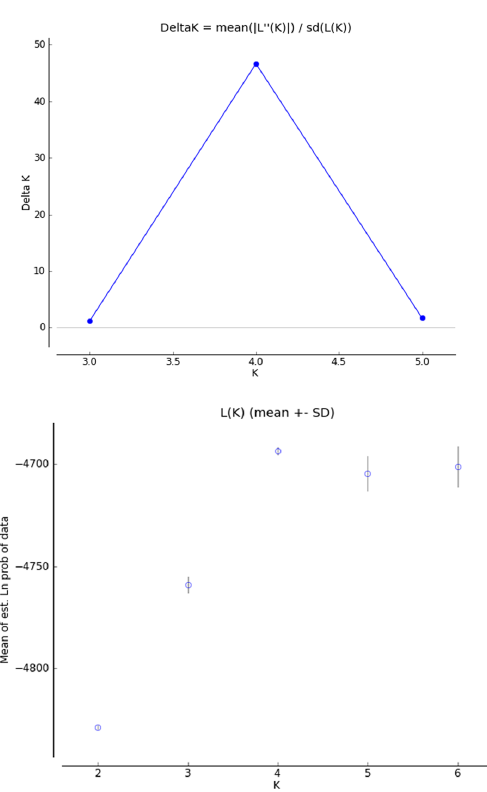
Figure 2. (cid:49)K value inferred with Structure Harvester.